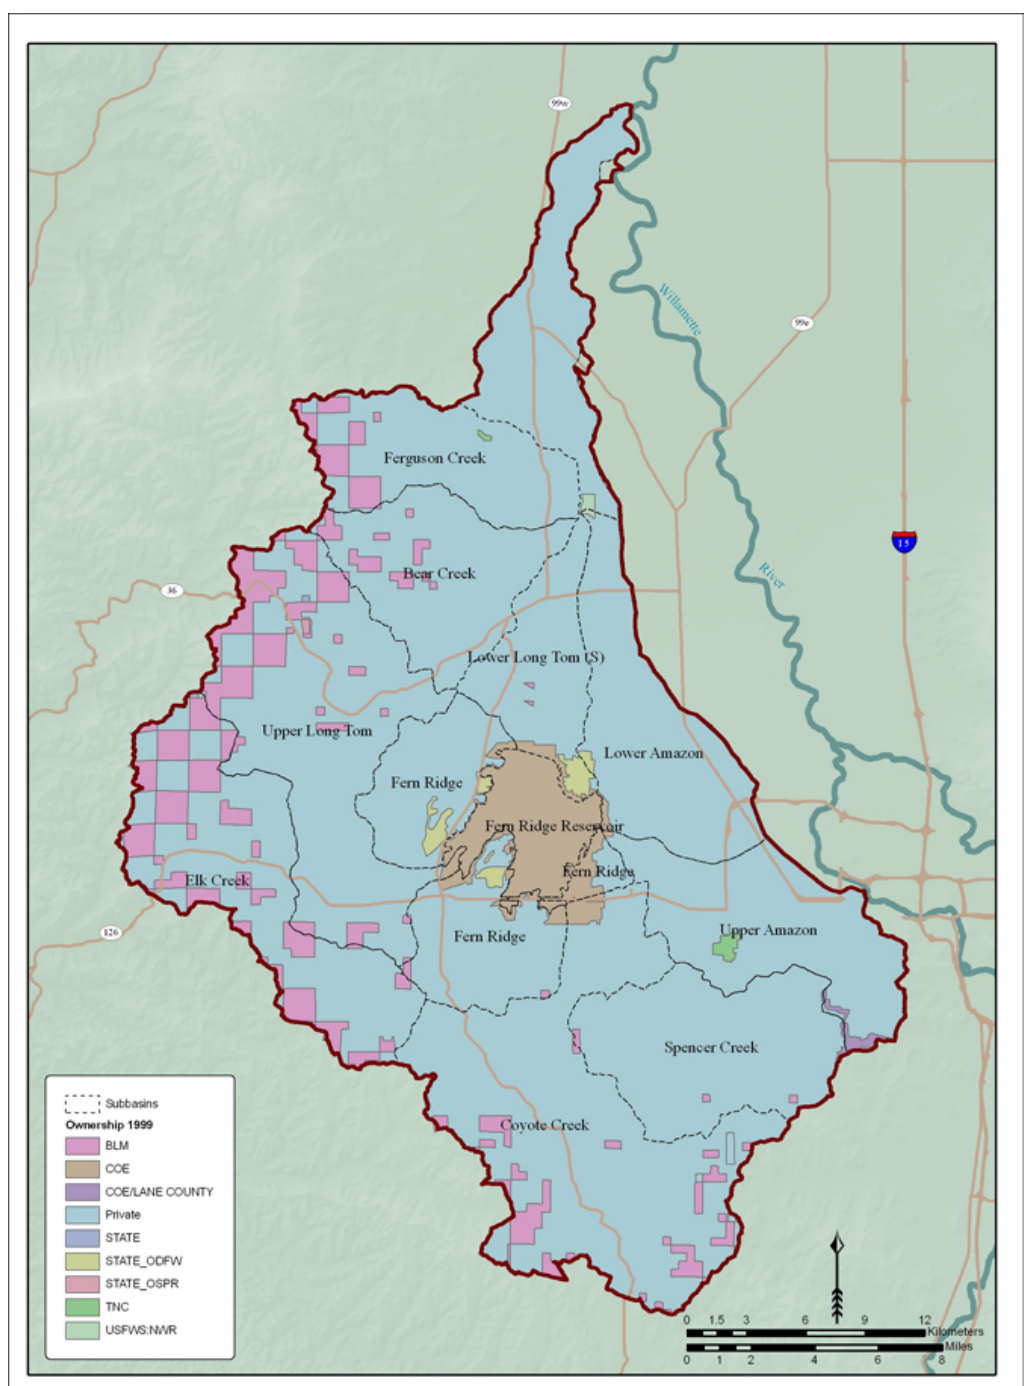
Fig. 3. Land ownership and subwatershed boundaries for the Long Tom River Watershed,